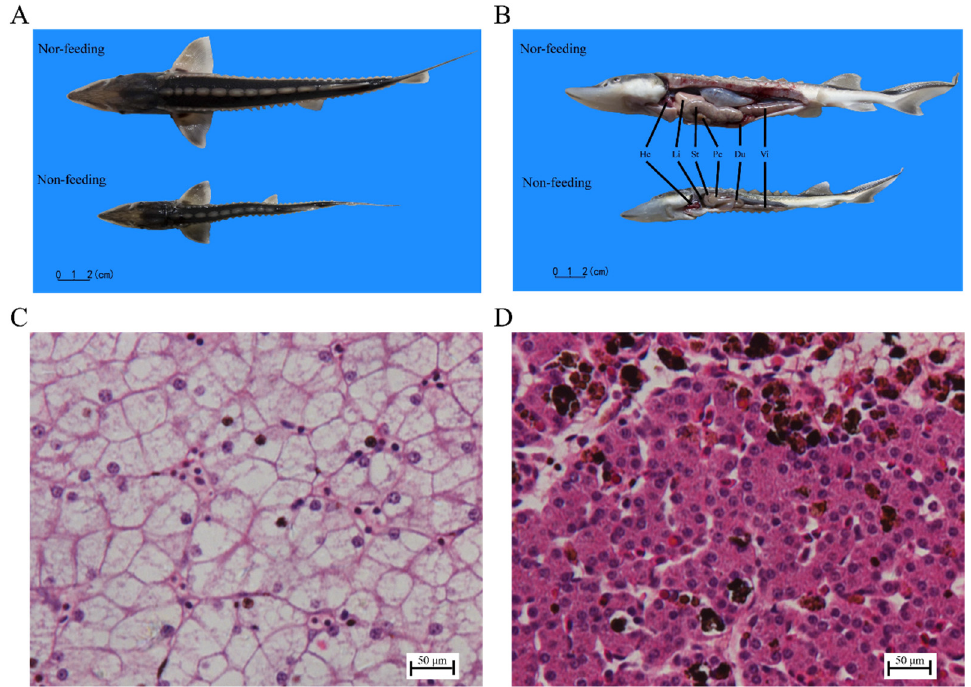
Figure 1. Weaning affected the liver health of Yangtze sturgeons. ( A , B ) Comparison of morphology and anatomy of Yangtze sturgeons. He: heart; Li: liver; St: stomach; Pc: pyloric caeca; Du: duodenum; Vi: valvula intestine. Images of HE-stained liver sections in ( C ) successful and ( D ) failed weaning Yangtze sturgeons (40×). Nor-feeding: successful weaning; non-feeding: failed weaning. Compared with the Success-Fish, the activities of aspartate aminotransferase (AST) and alanine aminotransferase (ALT) in the liver of the Failure-Fish increased significantly ( p < 0.05) (Figure 2).